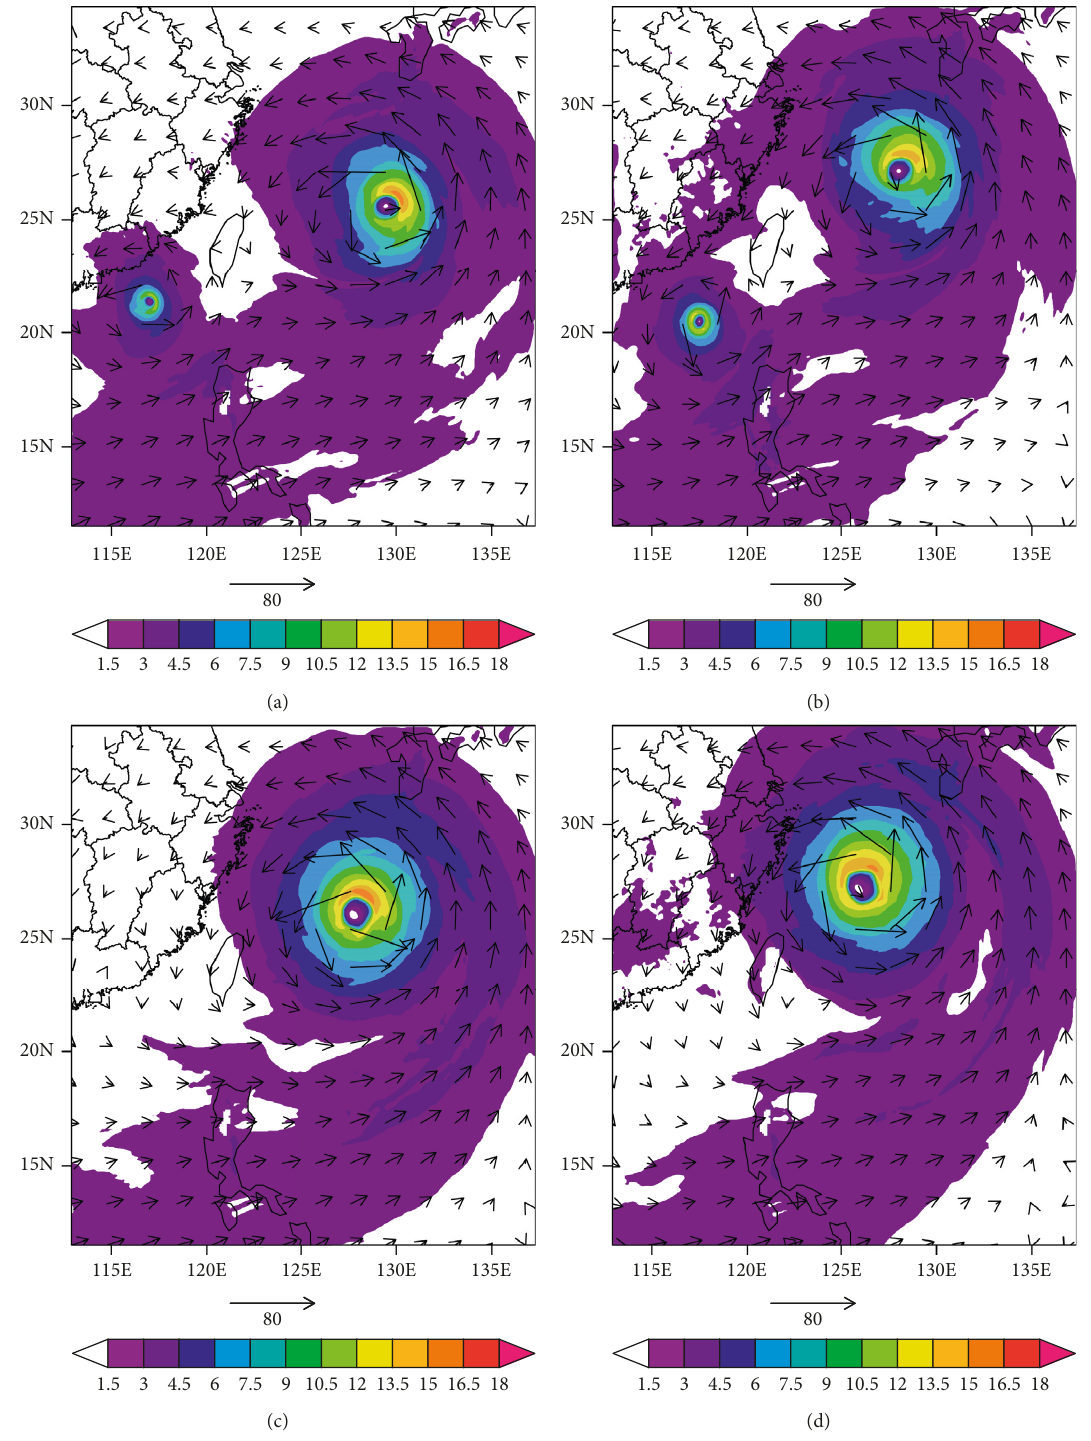
Figure 10: The 850hPa water vapor flux (shaded) at 0000 UTC 26 August (a, c) and 1200 UTC 26 August (b, d) in the CTL experiment (a, b) and the NoT experiment (c, d) (unit: kg hPa − 1 m − 1 s − 1